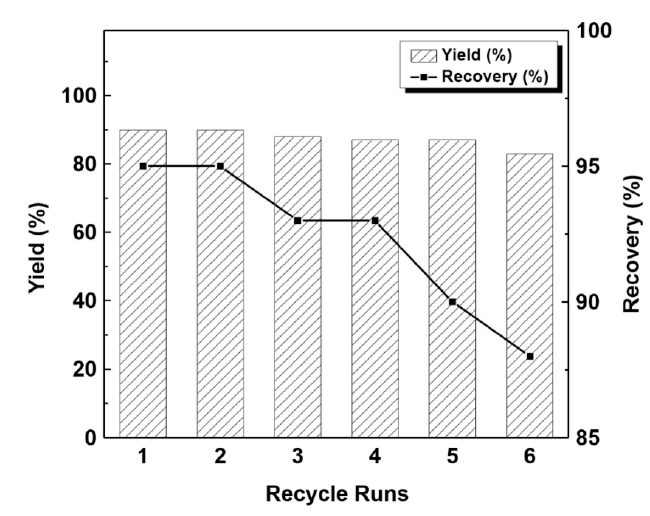
Figure 7. Catalyst recycling test in water of Au-SiO 2 @Fe 3 O 4 -RGO.